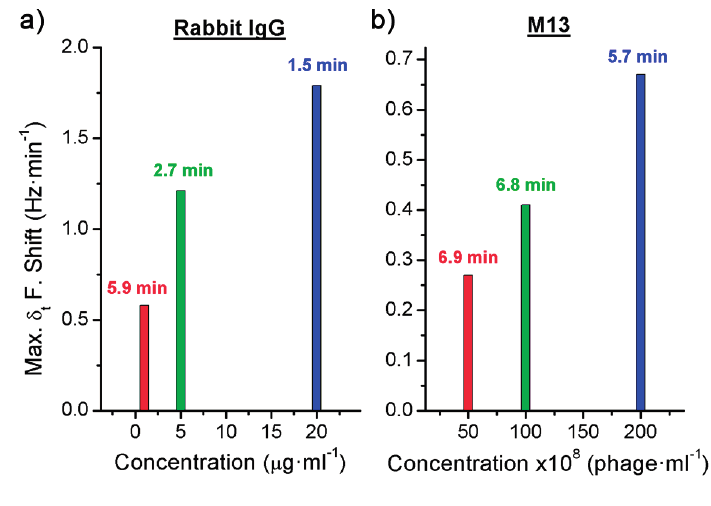
Figure 6. Maximum frequency shift per minute of the different concentrations ( a ) of the Rabbit IgG and ( b ) of the bacteriophage